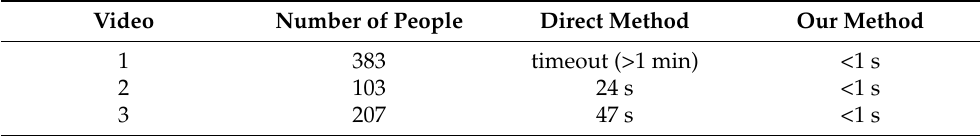
Table 4. Comparison between the search speed of the direct method and our method. In all cases, the direct method is unacceptably slow. When there are a large number of people in a video, the search time is so slow that it leads to an http request timeout, such as in the case of video